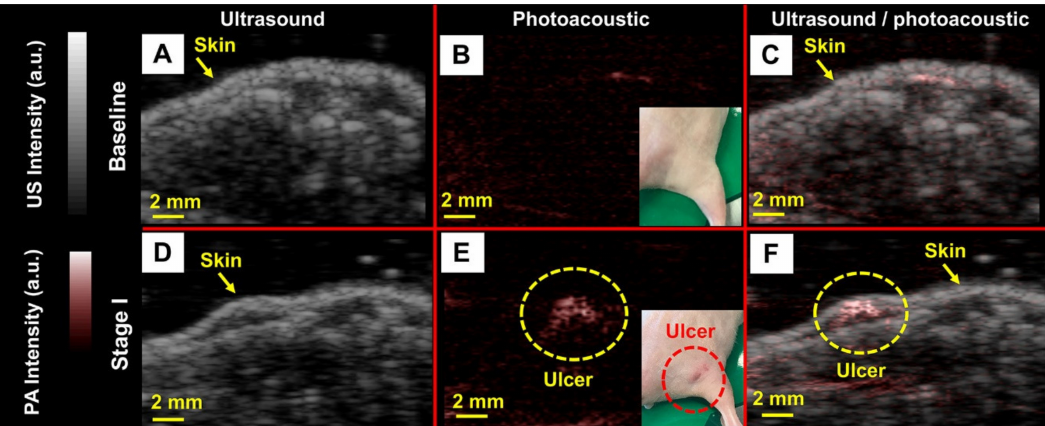
Figure 6. LED-based PA evaluation of pressure ulcers at stage I. ( A ) B-mode US image at baseline conditions when no pressure has been applied. ( B ) B-mode PA image at baseline at the same position as panel A. Minor PA signal is observed from the epidermis. The photographic inset shows the mouse in absence of ulcer. ( C ) B-mode PA / US overlay at baseline conditions. ( D ) B-mode US image at stage I. ( E ) B-mode PA image at stage I at the same position as panel D. We observed a 2.5-fold increase in PA intensity compared to baseline. The photographic inset shows the stage I ulcer. ( F ) B-mode PA / US overlay at stage I. The image depth is 1 cm and the scale bars are 2 mm. Reprinted with permission from Ref.